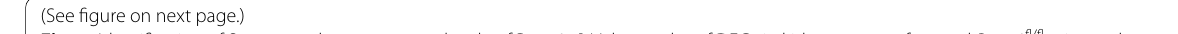
0.001(See figure on next Fig. 4 Identification of Soat1 as a downstream molecule of Pacs-2. A Volcano plot of DEGs in kidney cortex of control Pacs-2 fl/fl mice and control PT-Pacs-2 − / − mice. Splashes represent different genes, and the gray splashes mean genes without significant different expression. The red splashes mean significantly up-regulated genes in control PT-Pacs-2 − / − mice, and the blue splashes mean significantly down-regulated genes in control PT-Pacs-2 − / − mice. B Heat map of top eight DEGs involved in lipid metabolism; n 3 mice per group. C Real-time qRT-PCR showing the relative = mRNA expression of Soat1 . n 6 mice per group. D Representative immunofluorescence images of SOAT1 (green) in kidney tissues from each = group. The nuclei were delineated by DAPI (blue). n 6 mice per group. Bars 50 μm. E Semiquantification analysis of protein expression. F = = Representative western blot bands of SOAT1, n-SREBP1, n-SREBP2 expression in the kidney cortex, n 6 mice per group. G Relative band density. All = data are presented as means SD; *p < 0.05, **p < 0.01, ***p < ±